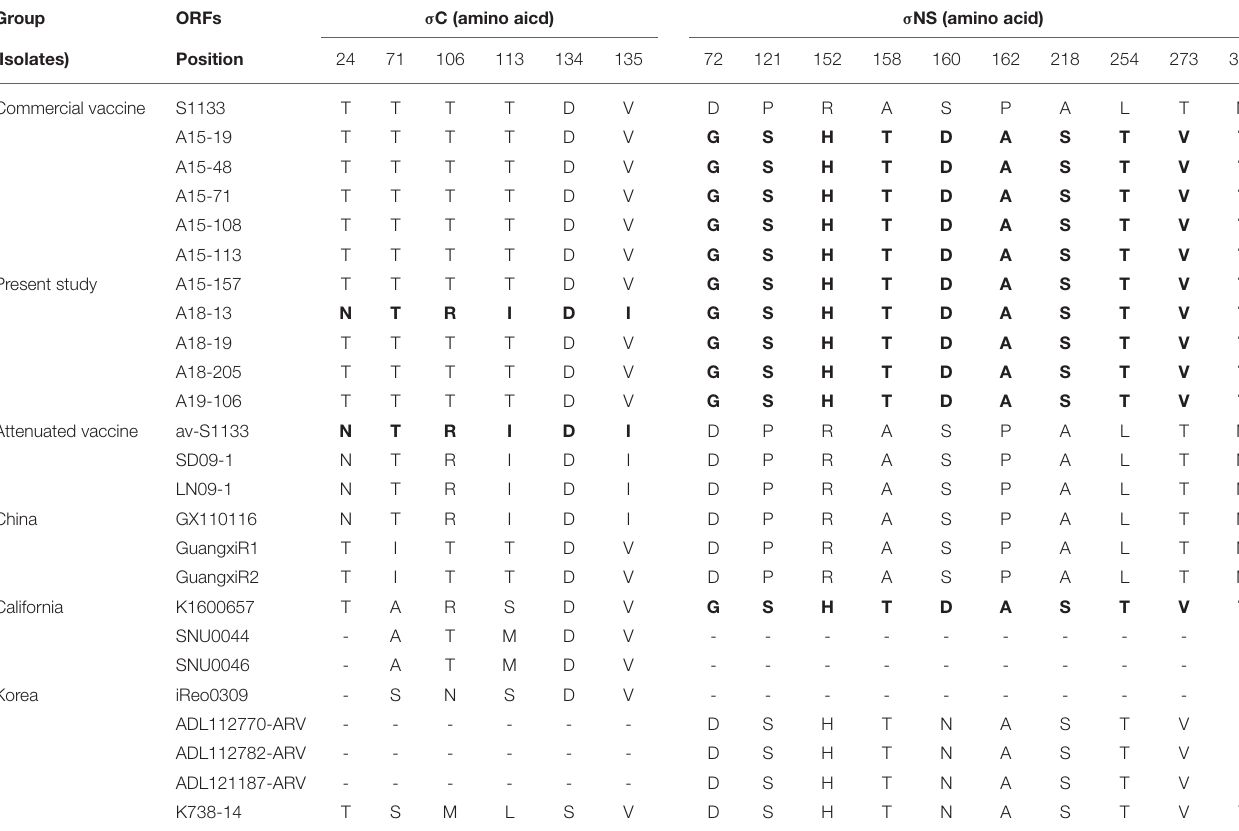
TABLE 3 | Deduced amino acid substitutions in the σ C- and σ NS-encoding genes of ARV isolates from wild bird. Group ORFs σ C (amino aicd) σ NS (amino acid) (Isolates) Position Commercial vaccine